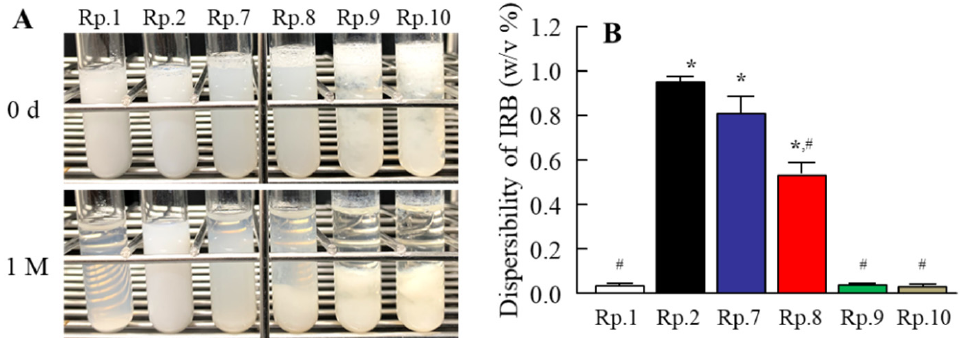
Figure 4. ( A ) Images and ( B ) dispersibility of the IRB immediately (0 d) and 1 m after redispersion of the IRB-NP tablet. The formulation of each Rp. is shown in Table 1, and the IRB tablets were suspended by purified water. n = 6. * p < 0.05 vs. Rp.1 for each category. # p < 0.05 vs. Rp.2 for each category. The gum arabic contents decreased the dispersibility of IRB in the redispersed IRB-NP tablets. In particular, the addition of more than 12 w / w % gum arabic resulted in a significant aggre- gation of IRB in the redispersions. Table 3. Particle sizes of IRB in the redispersions of 1-month-stored IRB-NP tablets. Formulation